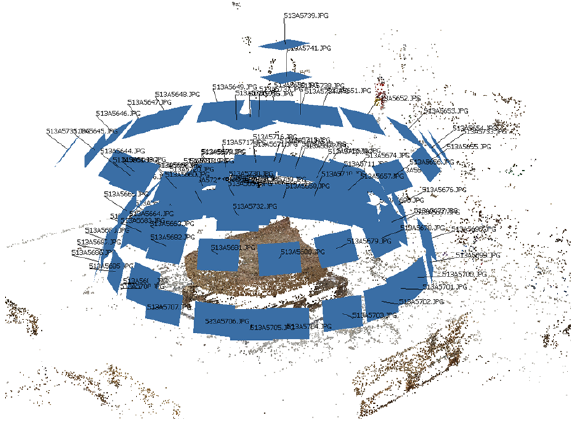
Figure 6: Illustration of image acquisition series for a